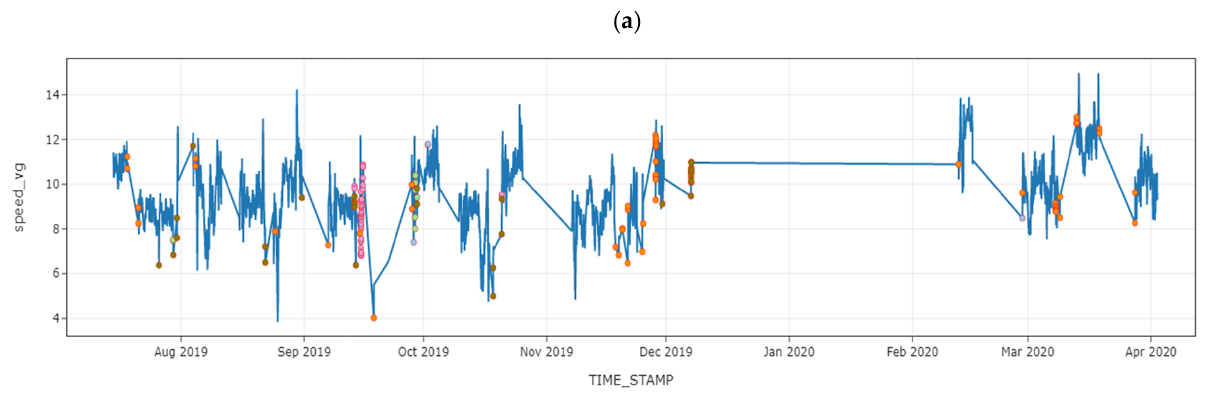
( f ) Figure 19. Anomalies plotted over the vessel routes: ( a ) cluster 1; ( b ) cluster 2; ( c ) cluster 3; ( d ) cluster 4; ( e ) cluster 5; ( f ) all cluster.